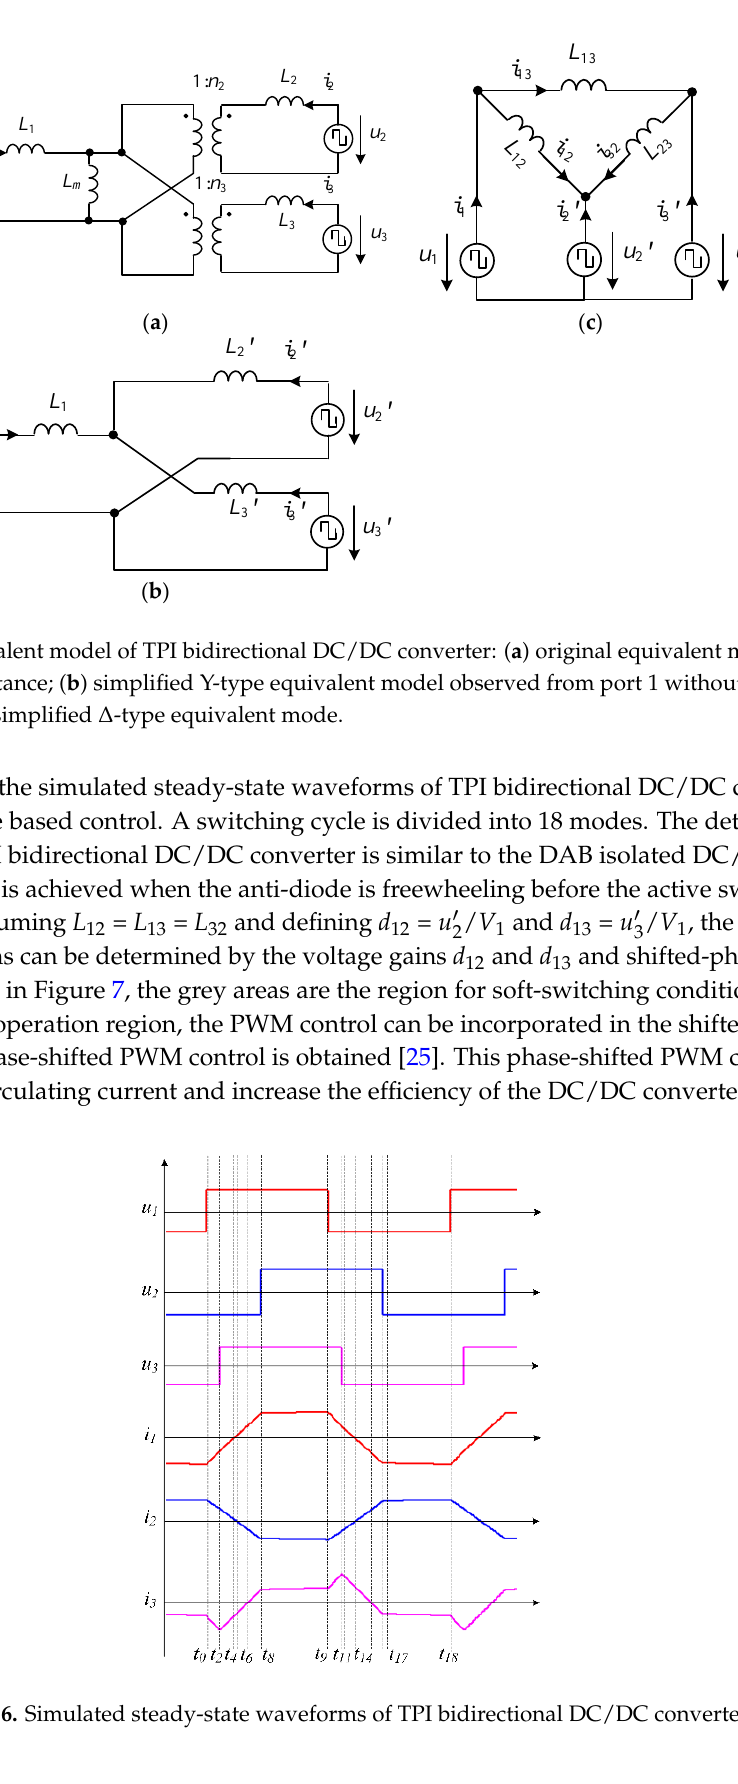
Figure 6. Simulated steady-state waveforms of TPI bidirectional DC/DC converter.